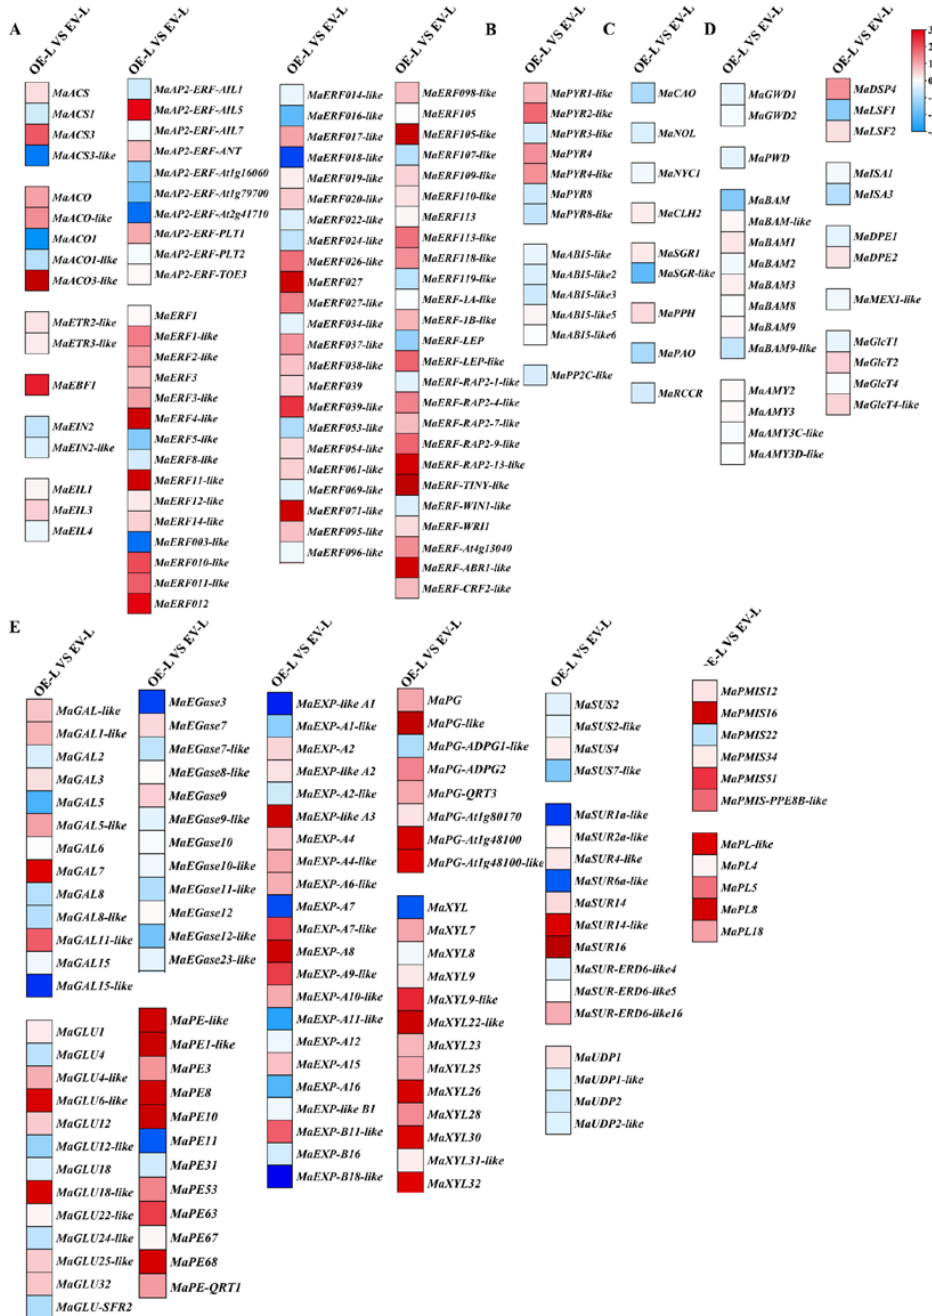
Figure 7. The expression profiles of the key DEGs for different pathways involved in fruit ripening in WT and MaERF012 -overexpression lines in peel using a heatmap. ( A – E ) DEGs in ethylene synthesis and the signal pathway ( A ), the ABA signal pathway ( B ), Chl degradation-related genes ( C ), starch degradation-related genes ( D ), and cell wall degradation-related genes ( E ). Transcription data were taken from RNA-seq and the heatmap was drawn using TBTools. The red and blue color indicated the up- or down-regulation, respectively.